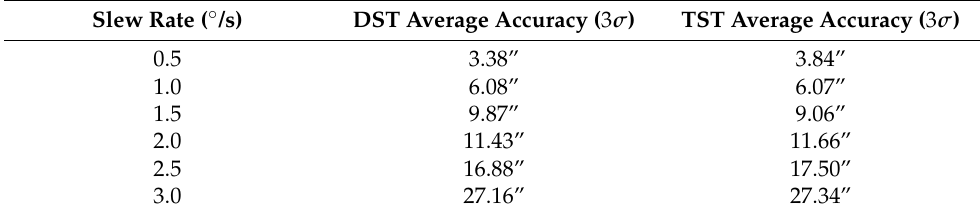
Table 7. The average accuracy (3 σ ) for DST and TST under slew rate of 0.5, 1.0, 1.5, 2.0, 2.5 and 3.0 ◦